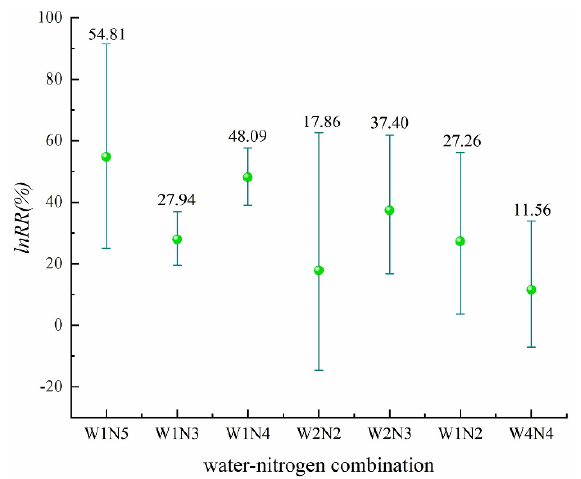
Figure 1. ( a ) Effect of different irrigation schedules on rice yield ( p = 0.00000); ( b ) effect of different nitrogen application levels on rice yield ( p = 0.00011).